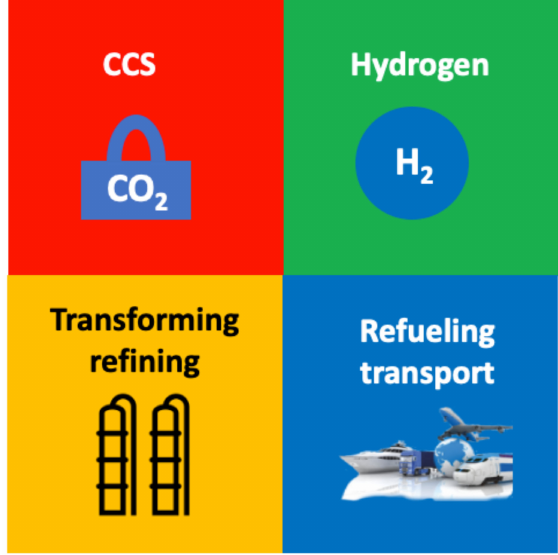
Figure 5. Four components of the decarbonization